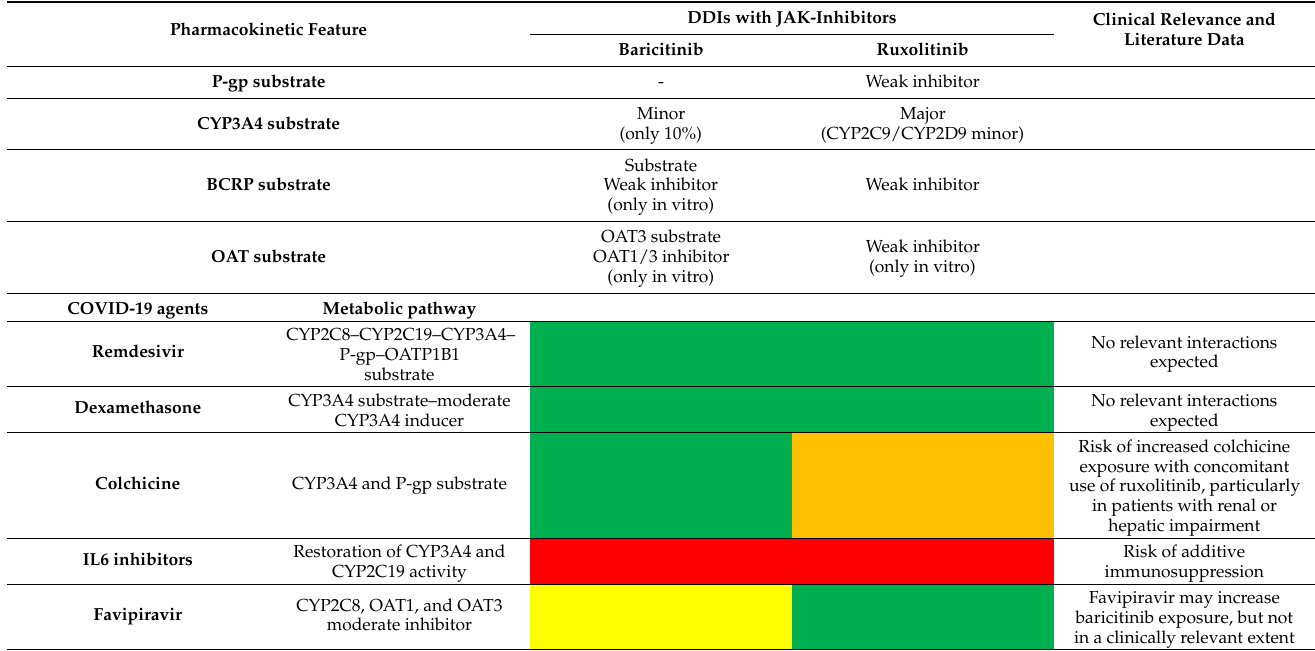
RED BOX: avoid co-administration (contraindicated or not recommended). ORANGE BOX: potential interaction (caution should be exercised and consider dose adjustment or alternative drugs). YELLOW BOX: potential weak interaction (monitoring for potential underexposure or toxicity). GREEN BOX: no interaction expected based on pharmacokinetic properties, although no clinical data exist. DDIs were checked through covid19-druginteractions.org/checker. BCRP: breast cancer resistance protein; CYP: cytochrome P450; OAT: organic anion transporter; and P-gp: glycoprotein